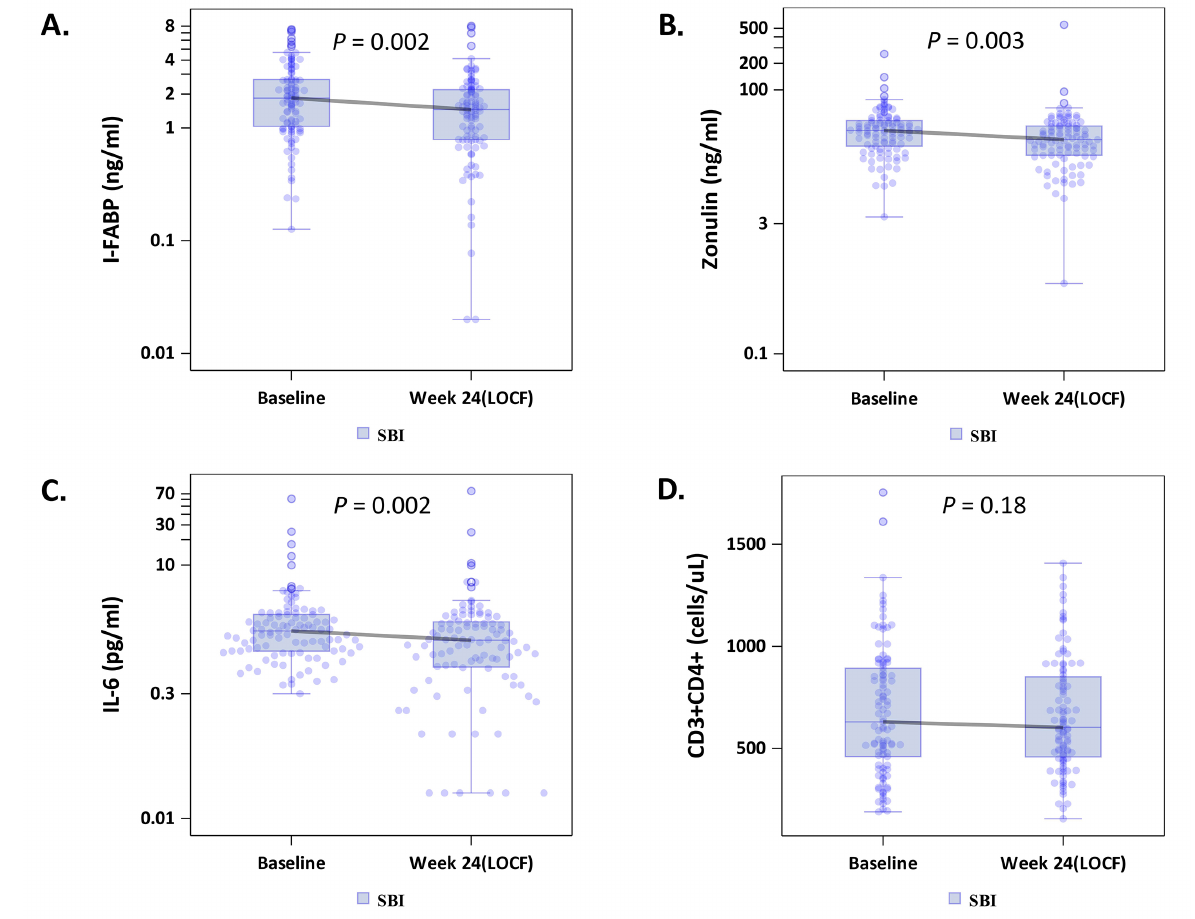
Figure 1. Effects of serum bovine immunoglobulin/protein isolate (SBI) on biomarkers of intestinal per- meability (A-B; intestinal fatty acid binding protein [I-FABP], zonulin), (C) inflammation (IL-6) and (D) CD4+ T cell counts among all